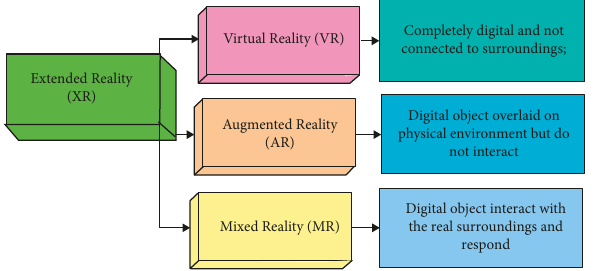
Figure 13: Comparison of VR, AR, and